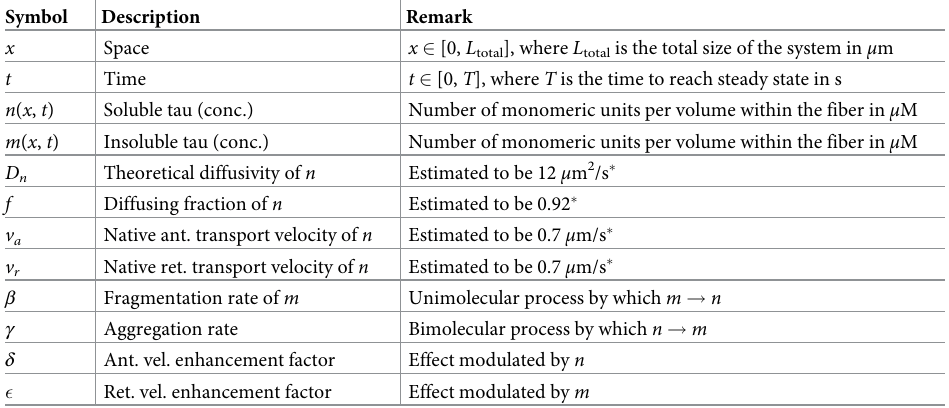
Table 1. Glossary of symbols used throughout the text. Values marked with an asterisk were estimated by Konzack